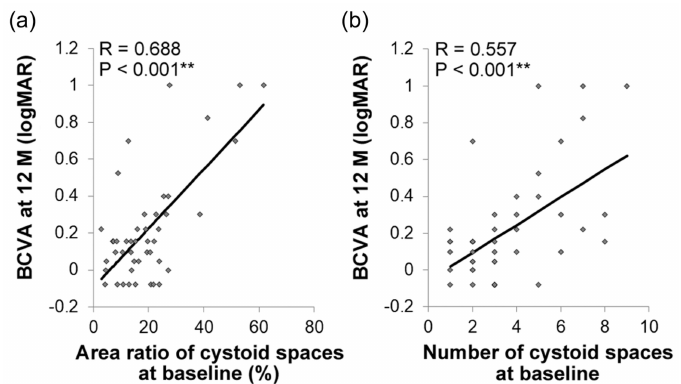
Figure 2. Association of the area ratio and number of intraretinal cystoid spaces at baseline with best-corrected visual acuity (BCVA) 12 months after intravitreal ranibizumab monotherapy. Pearson correlation coe ffi cient. The area ratio ( a ) and number ( b ) of intraretinal cystoid spaces at baseline were significantly correlated with BCVA at 12 months. ** p < 0.01.